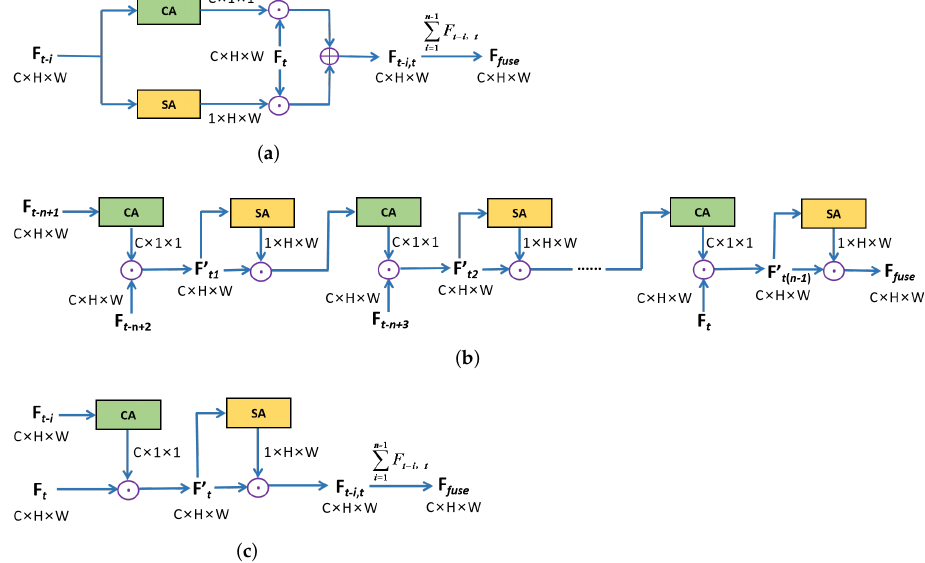
Figure 4. Three configuration modes for Spatial-Temporal Attention Module (STAM). ( a ) Parallel mode. ( b ) Serial mode. ( c ) The mixed